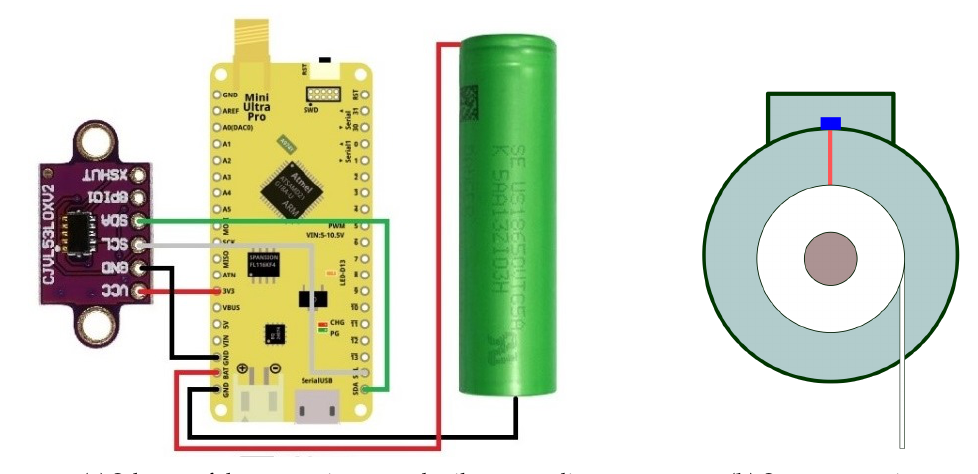
Figure 8. Toilet paper roll dispenser diagrams.